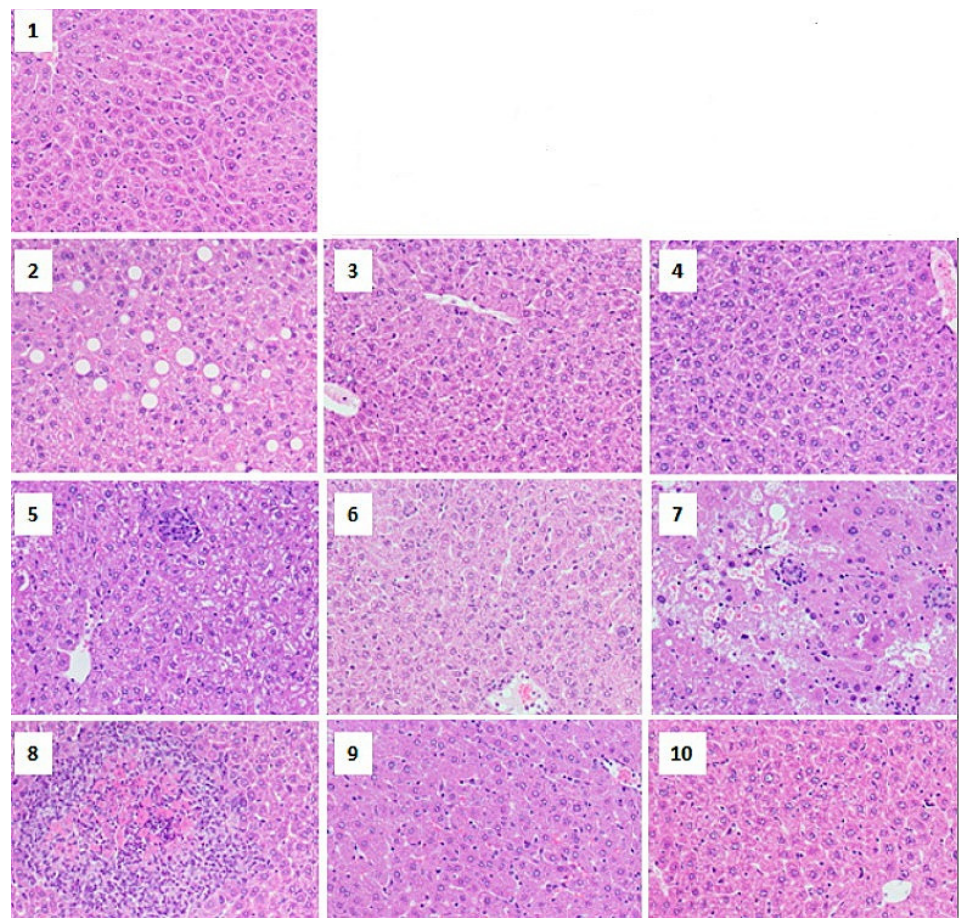
Figure 4. Histopathology of the liver after consuming 100 µL gold nanoparticles by different groups of Swiss albino female mice via intraperitoneal injection at different periods and particle size (PS). ( 1 ) Control mouse liver section showing normal hepatic architecture, ( 2 ) marked steatosis, and the abundance of micro and macro vesicles after one-day consumption at 5 nm, ( 3 ) and ( 4 ) look healthy with normal hepatocytes after one-day consumption at 20 nm and 50 nm, respectively, ( 5 ) cytoplasmic degeneration and some aggregation of inflammatory cells after seven days consumption at 5 nm, ( 6 ) looks healthy with mild activation of Kupffer cells after seven days con- sumption at 20 nm, ( 7 ) multi-necrotic foci filled with hemorrhage and also the presence of infiltra- tive cells after seven days consumption at 50 nm, ( 8 ) necrotic foci filled with edema and sur- rounded by inflammatory cells after one and seven days consumption at 5 nm, ( 9 ) and ( 10 ) look healthy with bi-nucleated cells and the activation of Kupffer cells after one and seven days con- sumption at 20 nm and 50 nm, respectively. Adapted from reference [120].